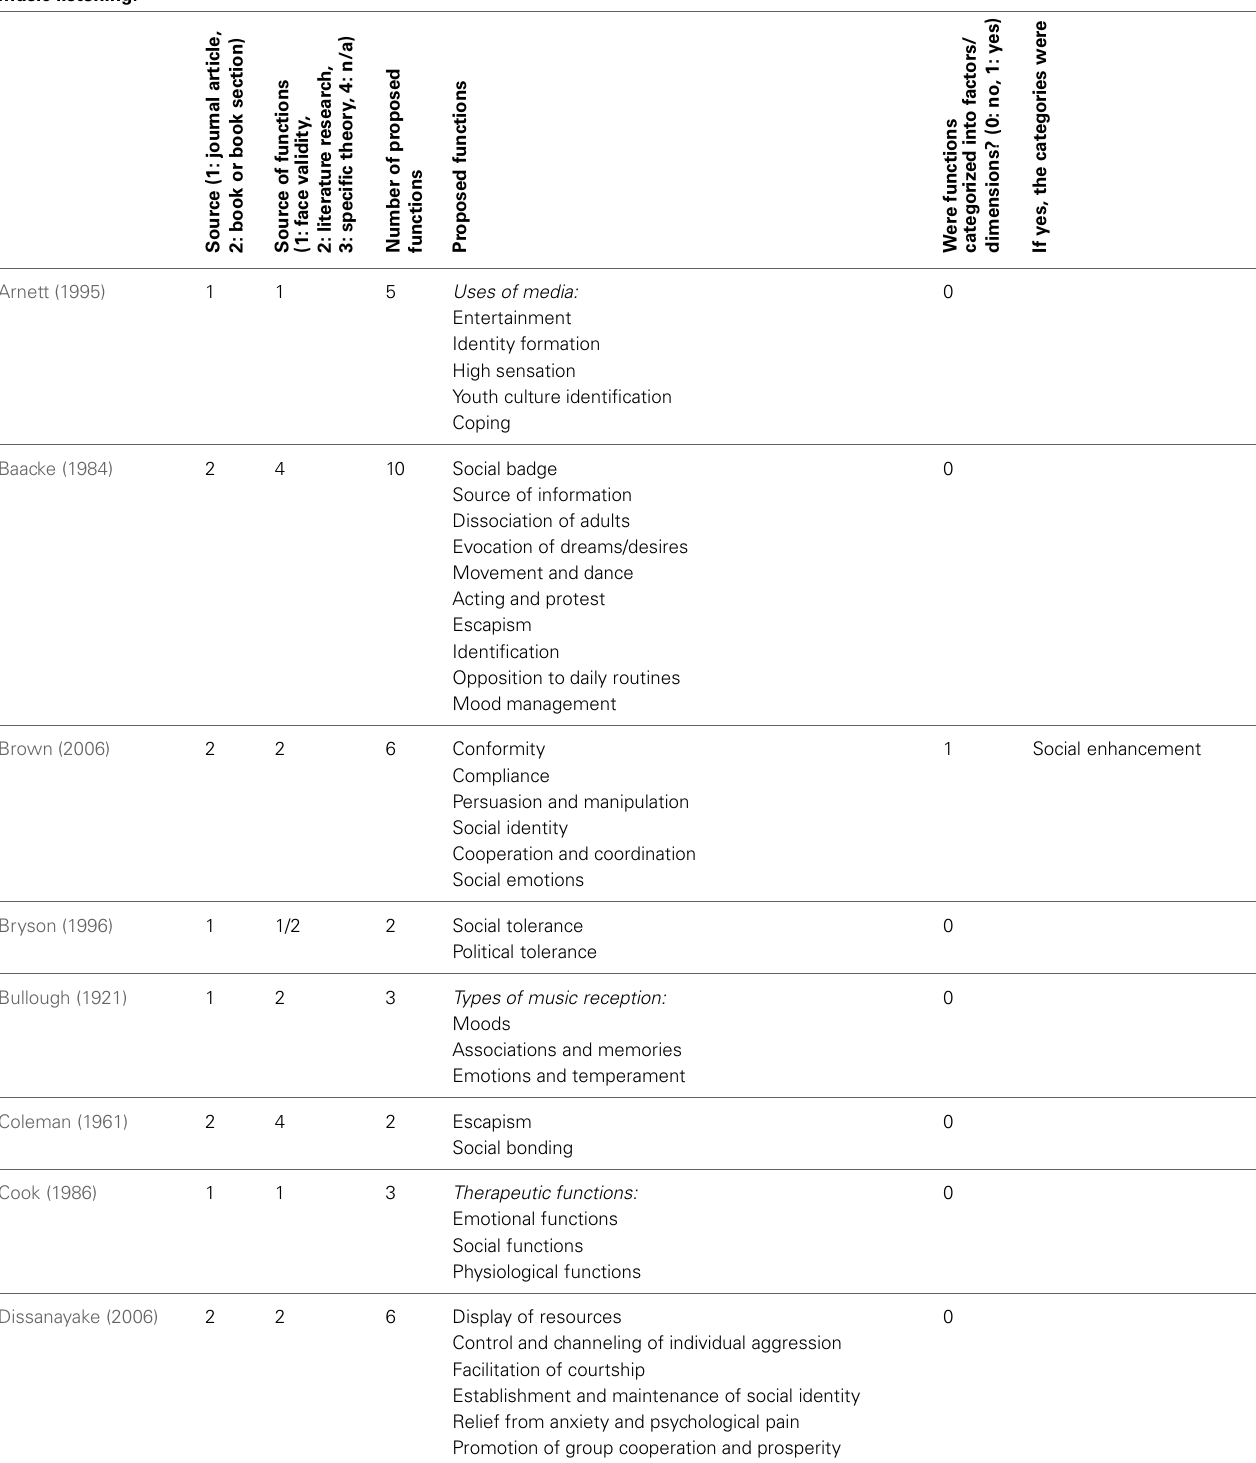
Table A1 | Overview of theoretical contributions that have derived, proposed, or addressed more than one function or functional aspect of music